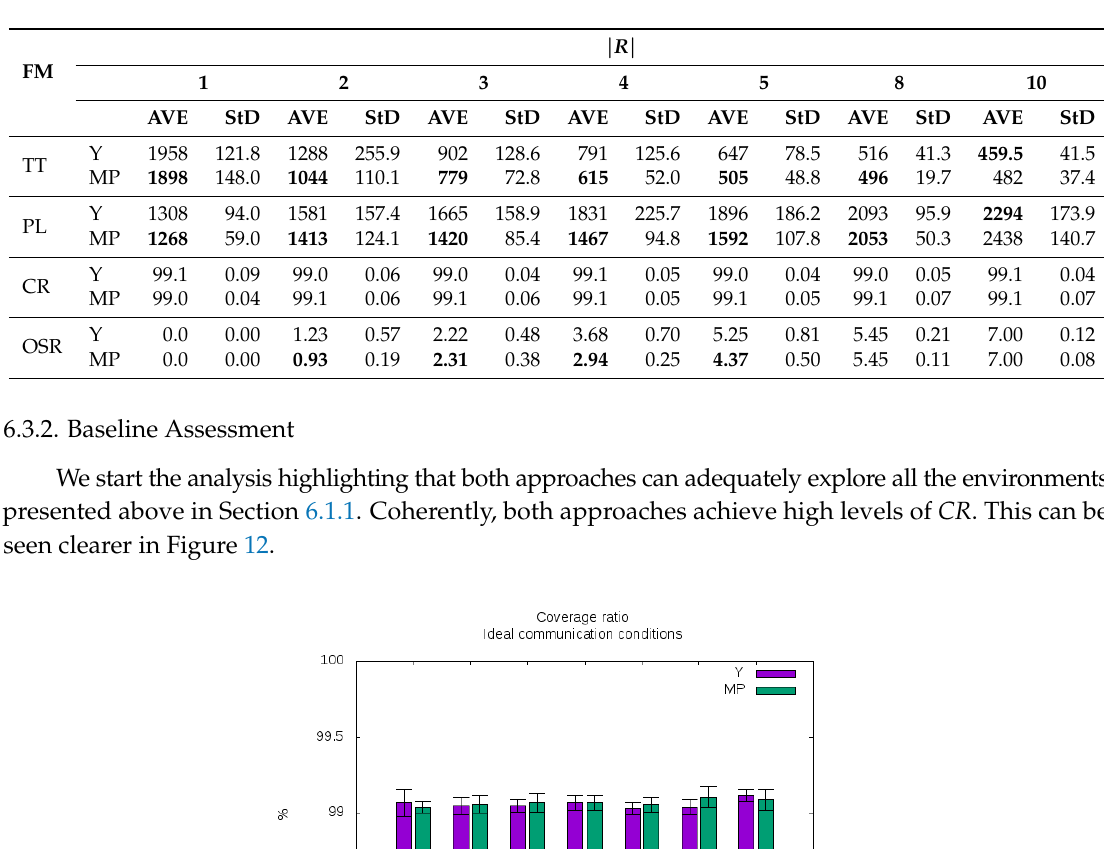
Table 4. Yamauchi and MinPos results under ideal communication conditions on Maze environment.